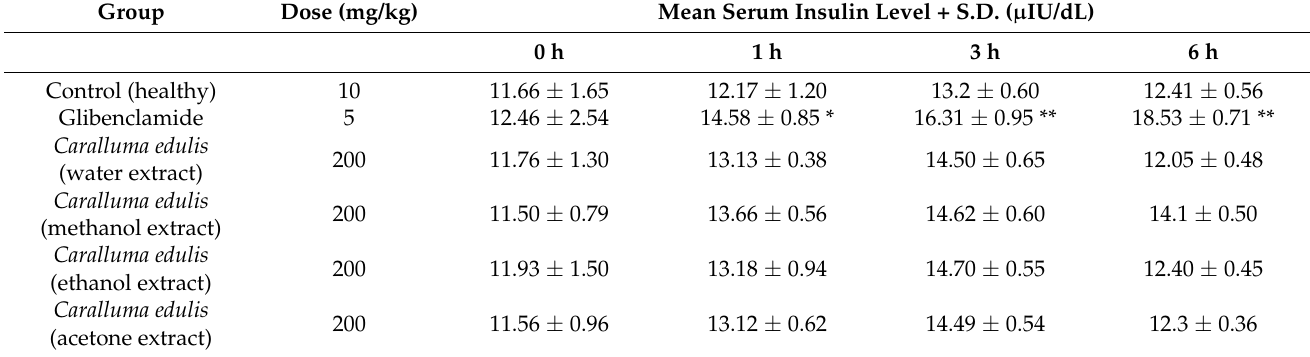
Table 7. Acute effect of Caralluma edulis extracts on serum insulin levels in alloxan-induced diabetic rabbits.